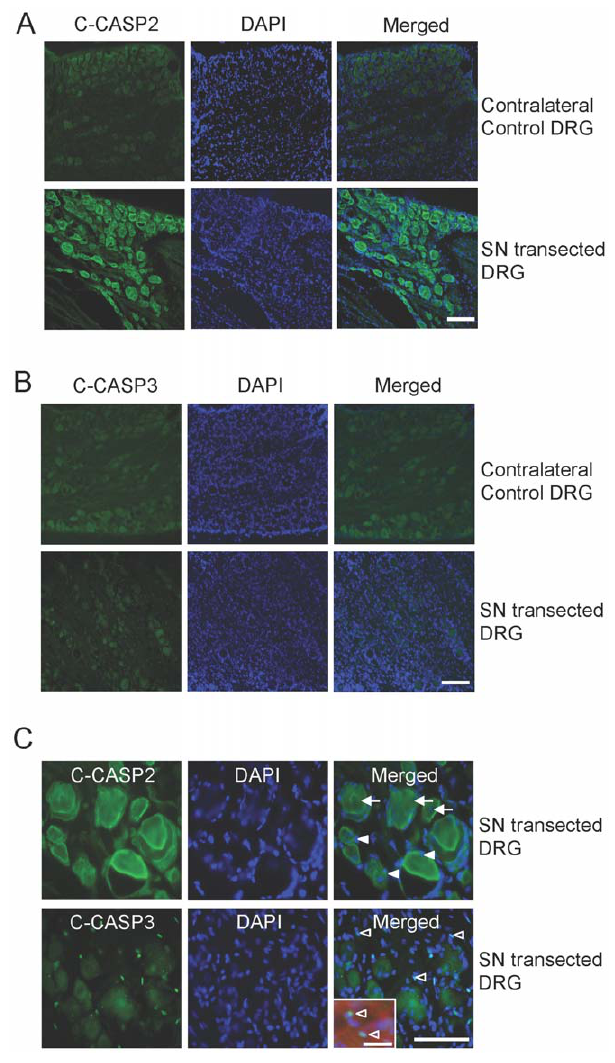
Figure 1. C-CASP2 is highly induced in DRGN and satellite cells after SN transection. A , B , Constitutive low levels of C-CASP2 and C- CASP3 in control DRGN and satellite cells, while high levels of C-CASP2 compared to C-CASP3 were observed in DRGN and satellite cells 1 month after SN transection. C , High power magnification showing C- CASP2 and C-CASP3 in DRGN (arrows) and satellite cells (arrowheads) and C-CASP3 in Schwann cells (open arrowheads). Inset in ( C ) shows high power magnification of double immunohistochemistry for p75 NTR and C-CASP2. Scale bar in A – C =50 m m.